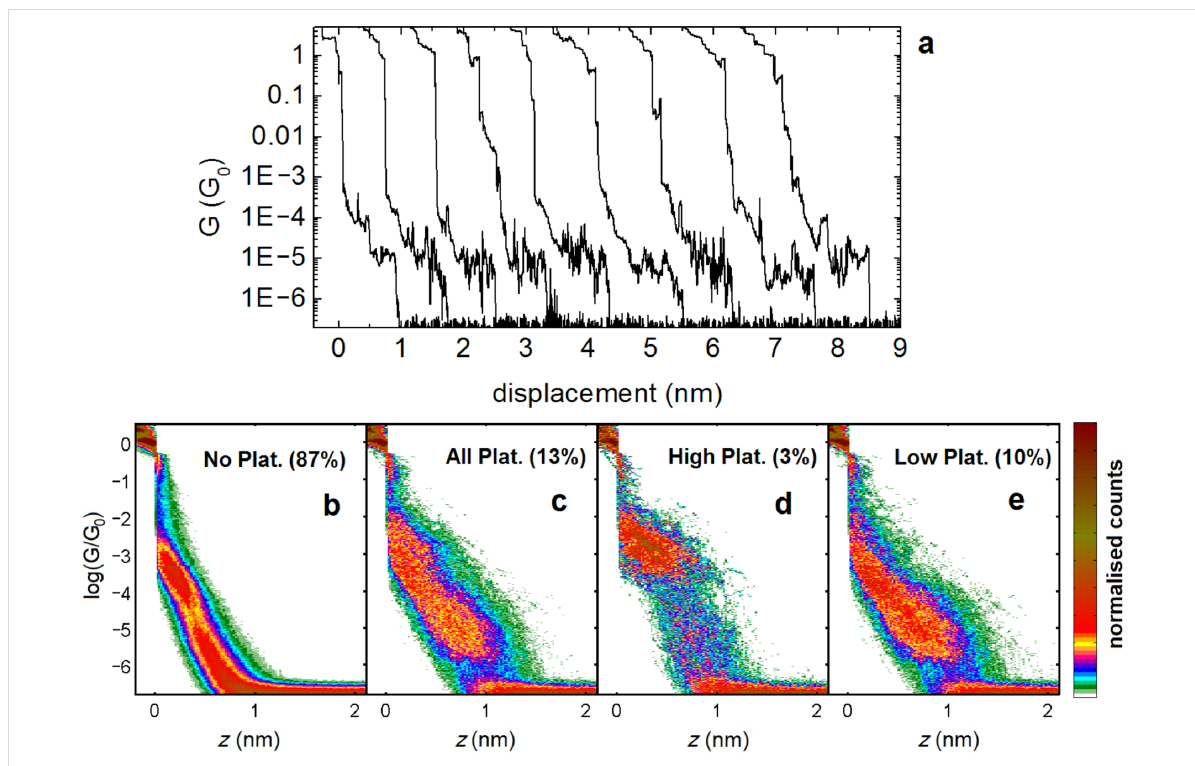
Figure 6: a) Examples of individual G( z ) traces showing clear conductance plateaus. b–e) 2D histograms corresponding to the CT complex between compound 5 and F 4 TCNQ after exposing a gold substrate to the solution of the complex in DCM. The traces are separated into four groups: b) traces without plateaus; c) traces with plateaus between log(G/G 0 ) = − 0.5 and − 6.0. From these traces the traces were divided into high and low plateau groups: d) traces with plateaus above log(G/G 0 ) = − 3.8; e) traces with plateaus below log(G/G 0 ) = − 3.8. The total number of traces recorded was